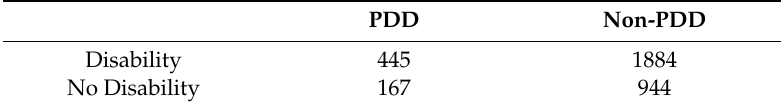
Table 2. Distribution of hand fine motor skill disabilities among patients with and without Parkinson’s disease-related dementia.